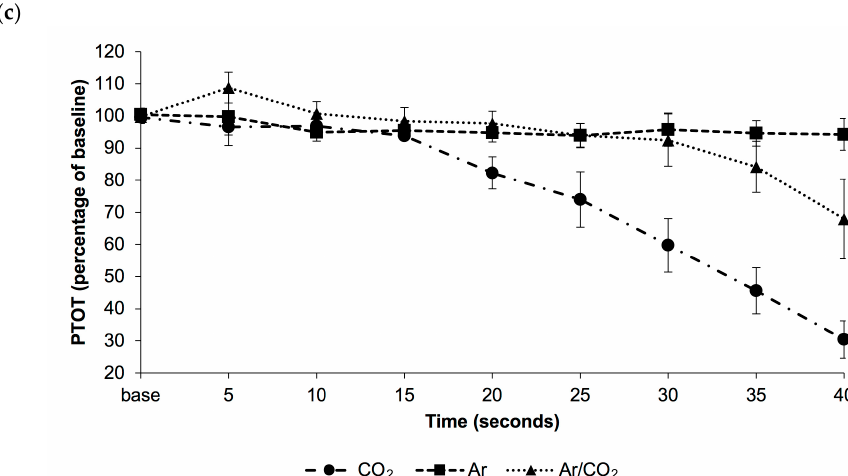
Figure 1. Mean ( ± SEM) changes in ( a ) median frequency (F50), ( b ) spectral edge frequency (F95) and ( c ) total power (PTOT) of the EEG over time in piglets subjected to gas euthanasia (n = 5/treatment) with 100% carbon dioxide (CO 2 ), 100% argon (Ar) or a mixture of 40% carbon dioxide/60% argon (Ar/CO 2